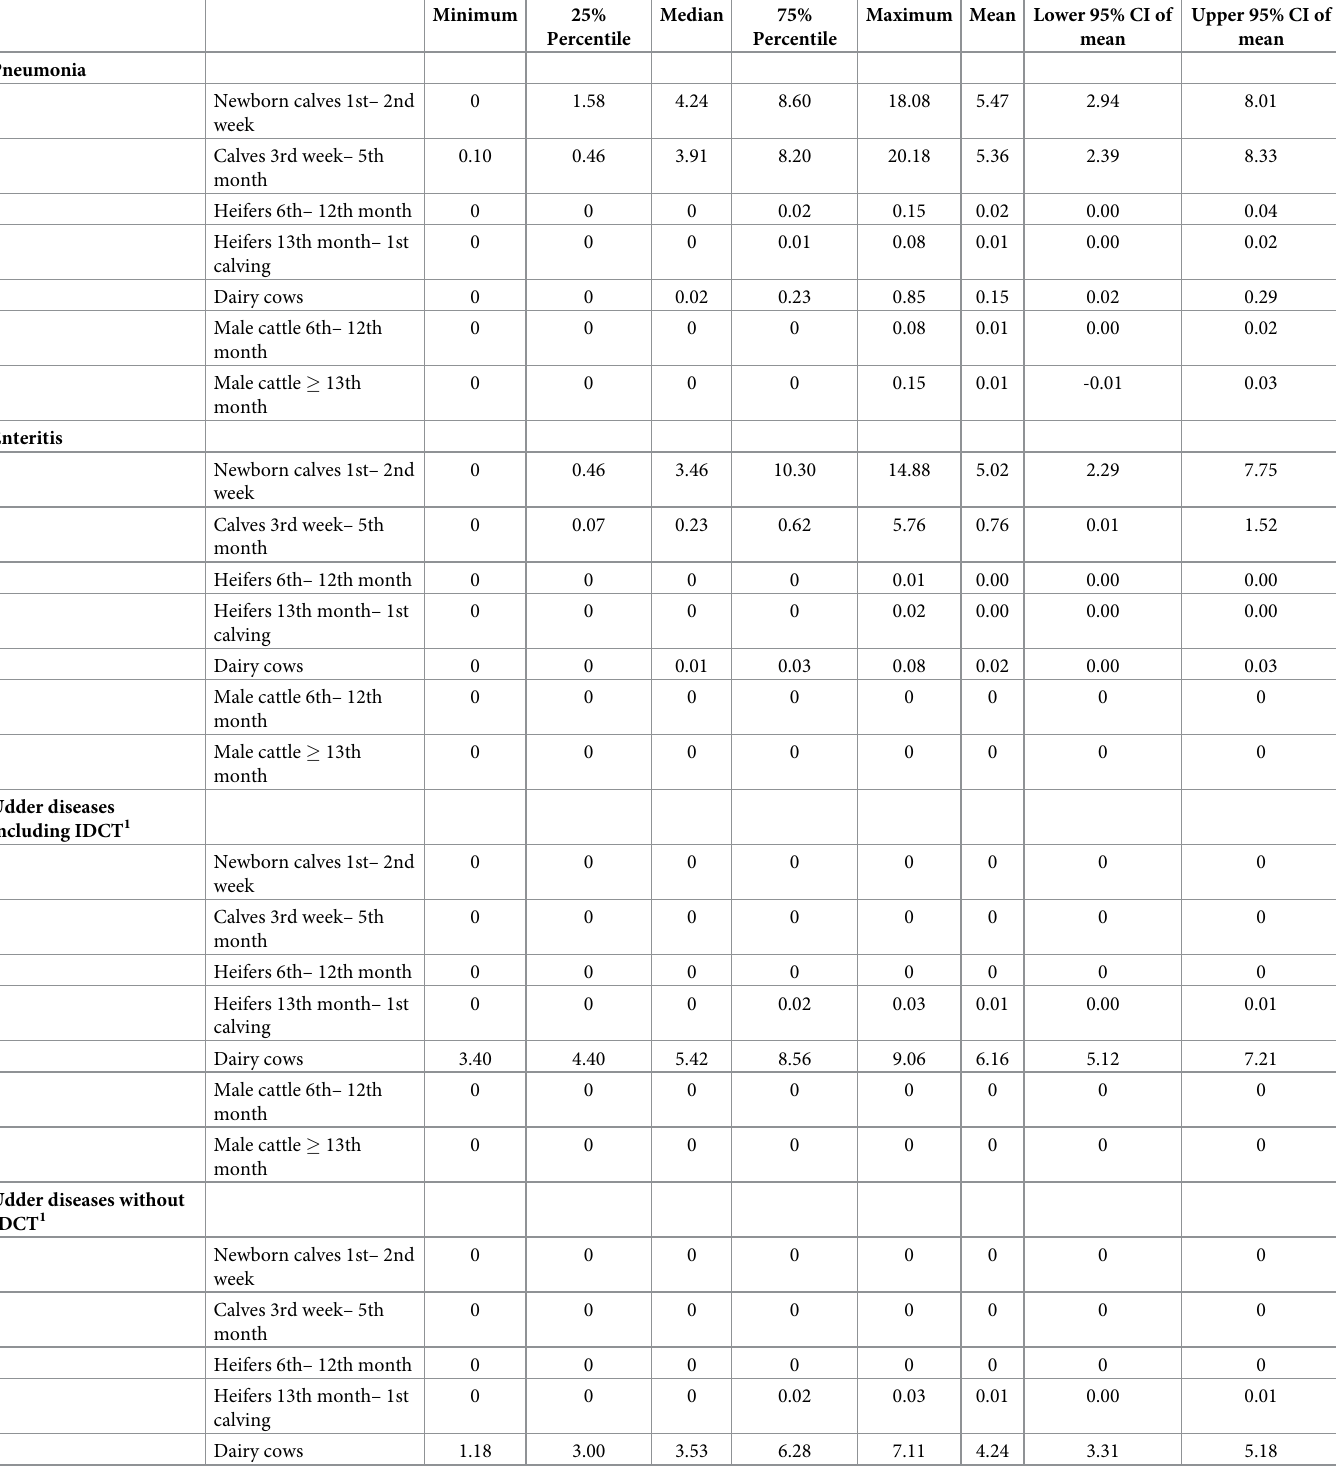
Table 6. Descriptive statistics of the treatment frequencies per year of the different age groups for different